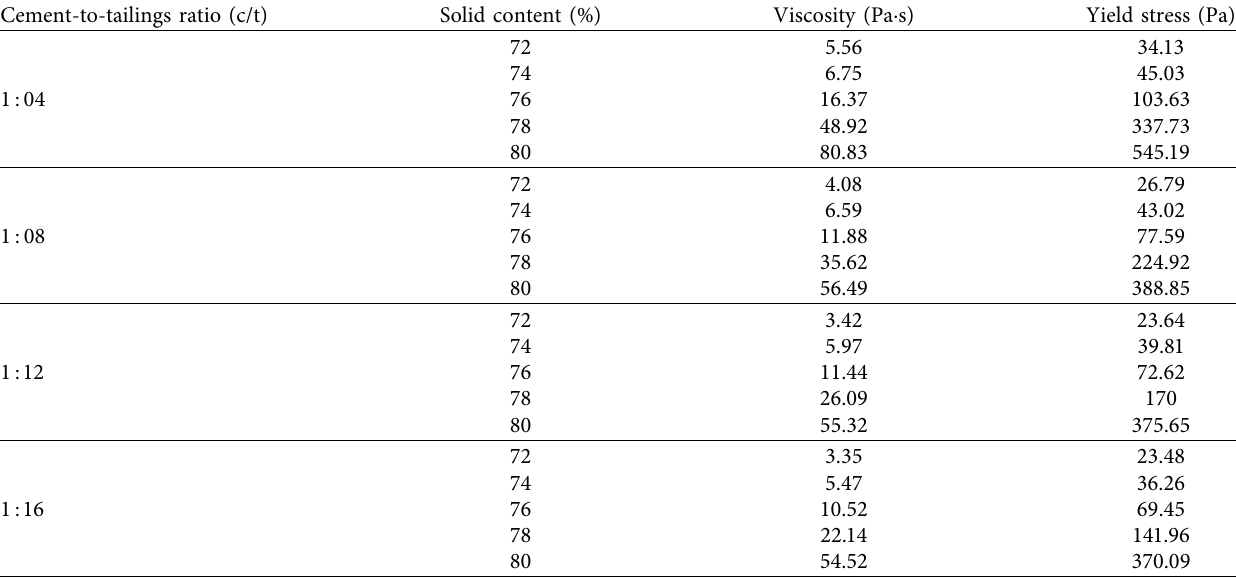
Table 4: Rheological parameters results of CUTB